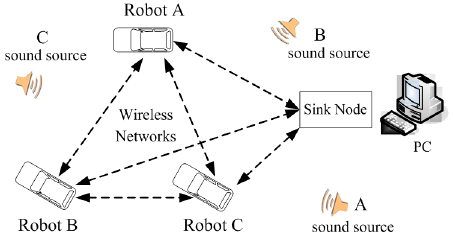
Figure 1. Architecture of three-robot system in WSN.